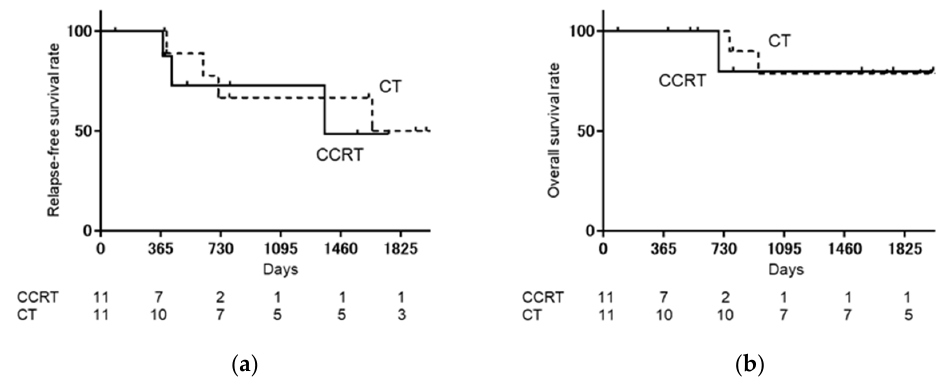
Figure 3. Kaplan–Meier analysis of relapse-free survival (RFS) and overall survival (OS) with multiple-lymph-node metastases. ( a ) Kaplan–Meier analysis of relapse-free survival (RFS) with multiple-lymph-node metastases; ( b ) Kaplan–Meier analysis of overall survival (OS) with multiple-lymph-node metastases. The CCRT with multiple-lymph-node metastasis group is compared with the chemotherapy with multiple-lymph-node metastasis group; there are no significant differences in RFS (log-rank: p = 0.7173, HR: 0.7617, 95%CI: 0.1633–3.553) and OS (log-rank: p = 0.8911, HR: 0.8607, 95%CI: 0.081–9.066) between them.